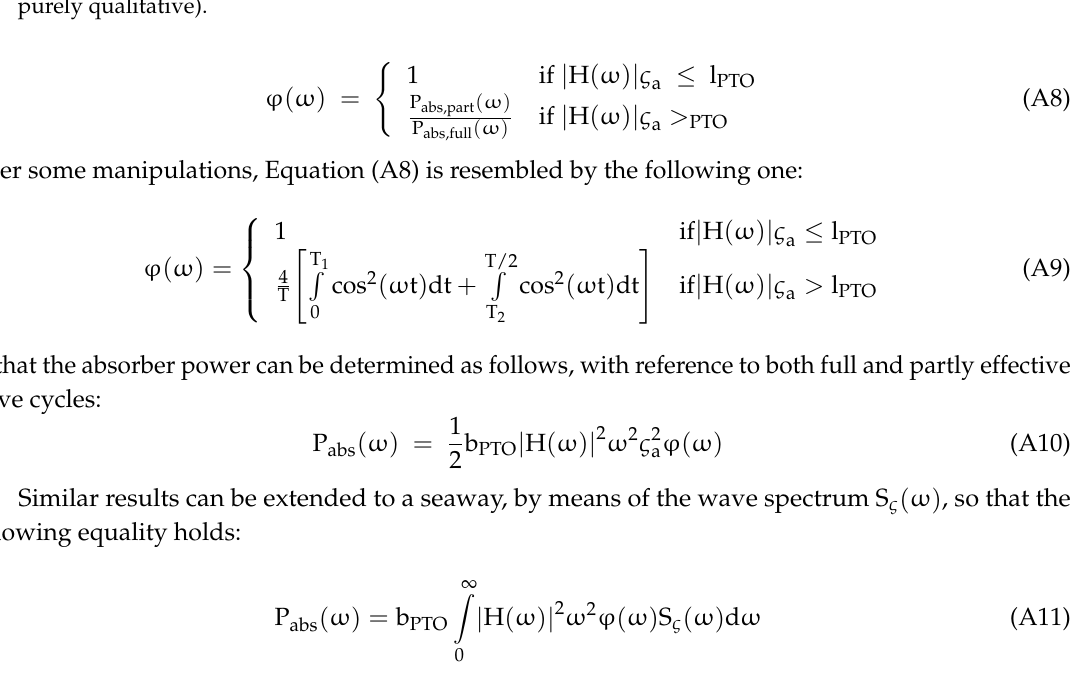
Figure A2. Power absorption with exceedance of PTO upper/lower stroke length (both graphs are purely